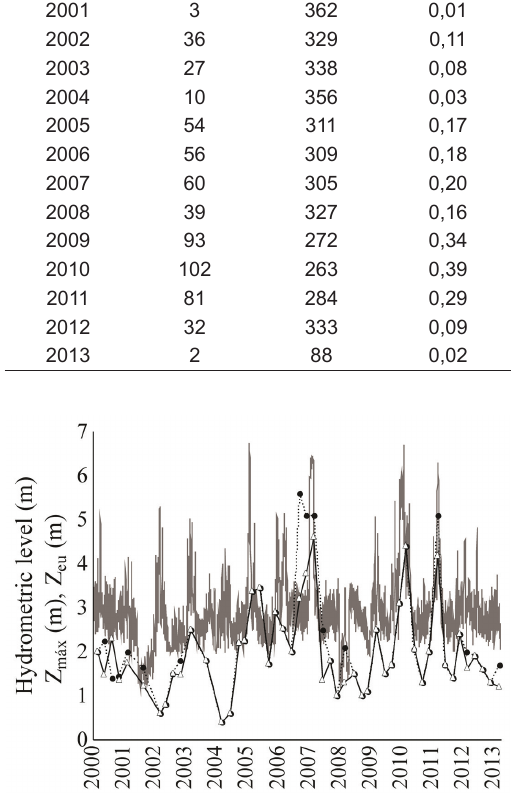
Figure 2. Hydrometric levels of the Paraná River (lines), Z (points) and Z (triangle) of the lake from February máx eu 2000 to March 2013. The sampling days are indicated by